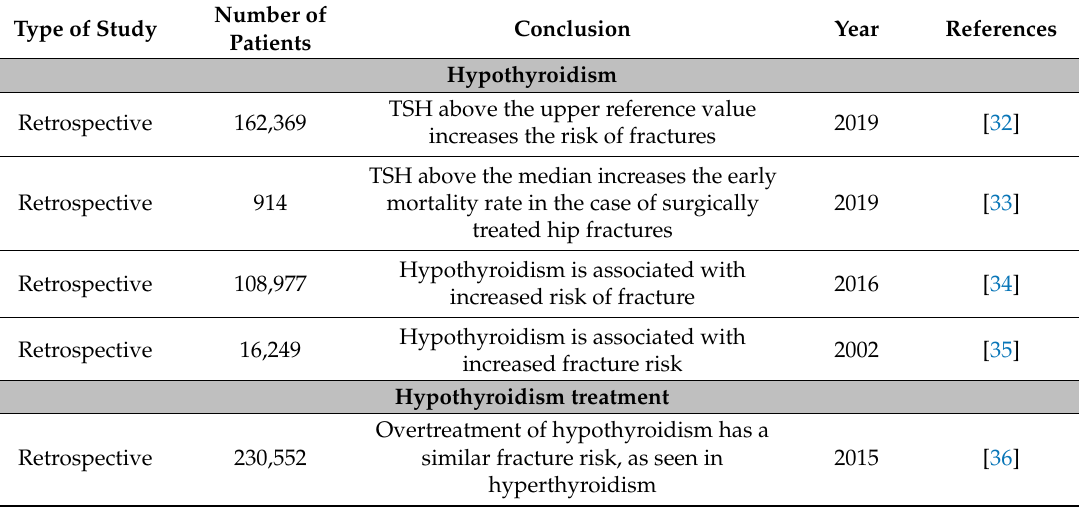
Table 2. Studies regarding the impact of hypothyroidism, autoimmune thyroid pathology, subclinical hypothyroidism, subclinical hyperthyroidism, and their treatments on fracture risk. TPOAb = thyroid